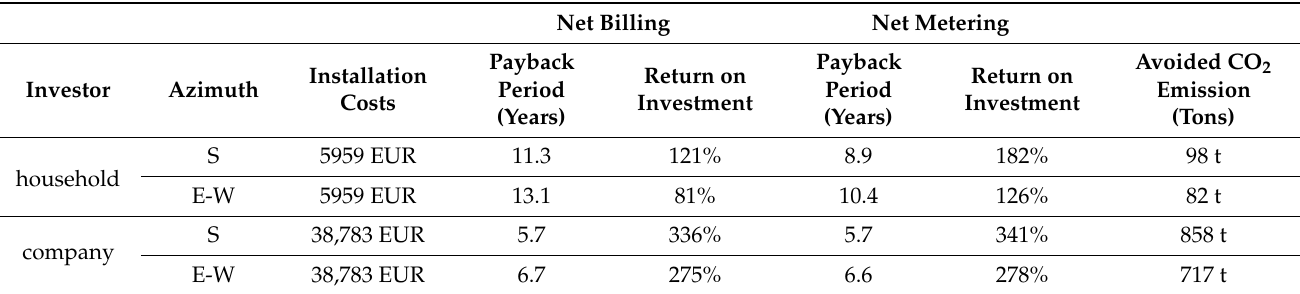
Table 4. Basic financial parameters for the considered PV systems taking into account currently in force in Poland—net billing and previous net metering photovoltaic support